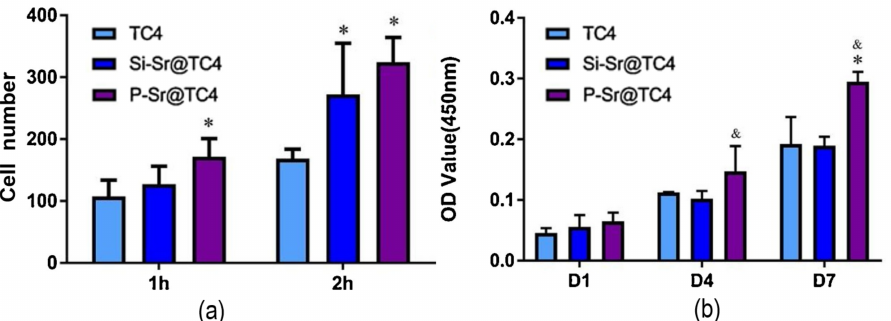
Figure 2. Cell adhesion and cell proliferation response ( a ) Number of adhered cells ( b ) cell prolifera- tion. (* indicates statistical significance < 0.05 vs. TC4, & indicates statistical significance < 0.05 vs. Si-Sr@TC4). Reprinted with permission from